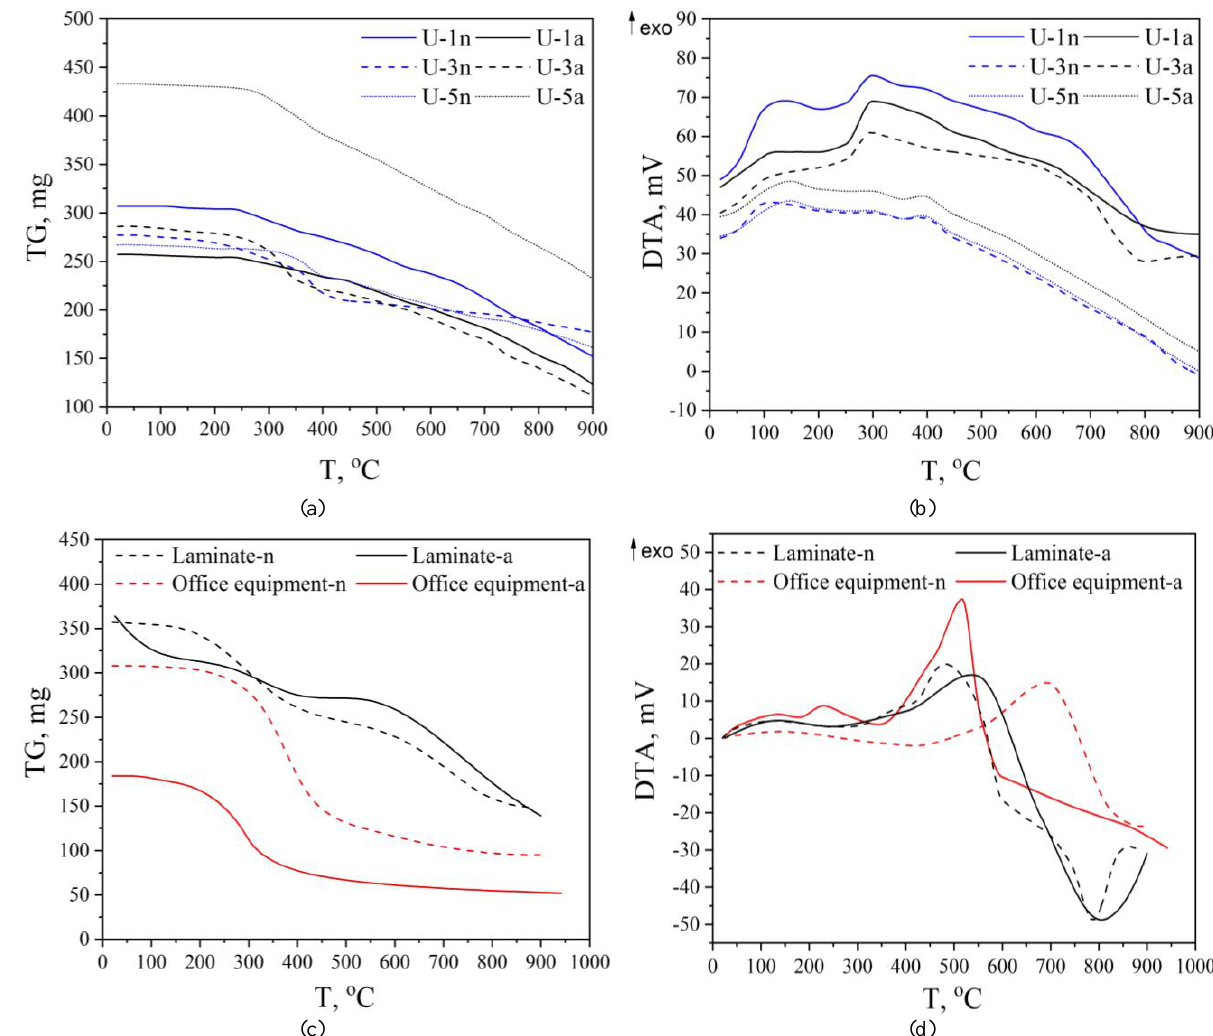
Figure 3. Results of thermographic analyses of waste PCMs: a, c–mass change curves (T-G), b, d–temperature derivative curves (DTA) of PCM samples (a – air, n -